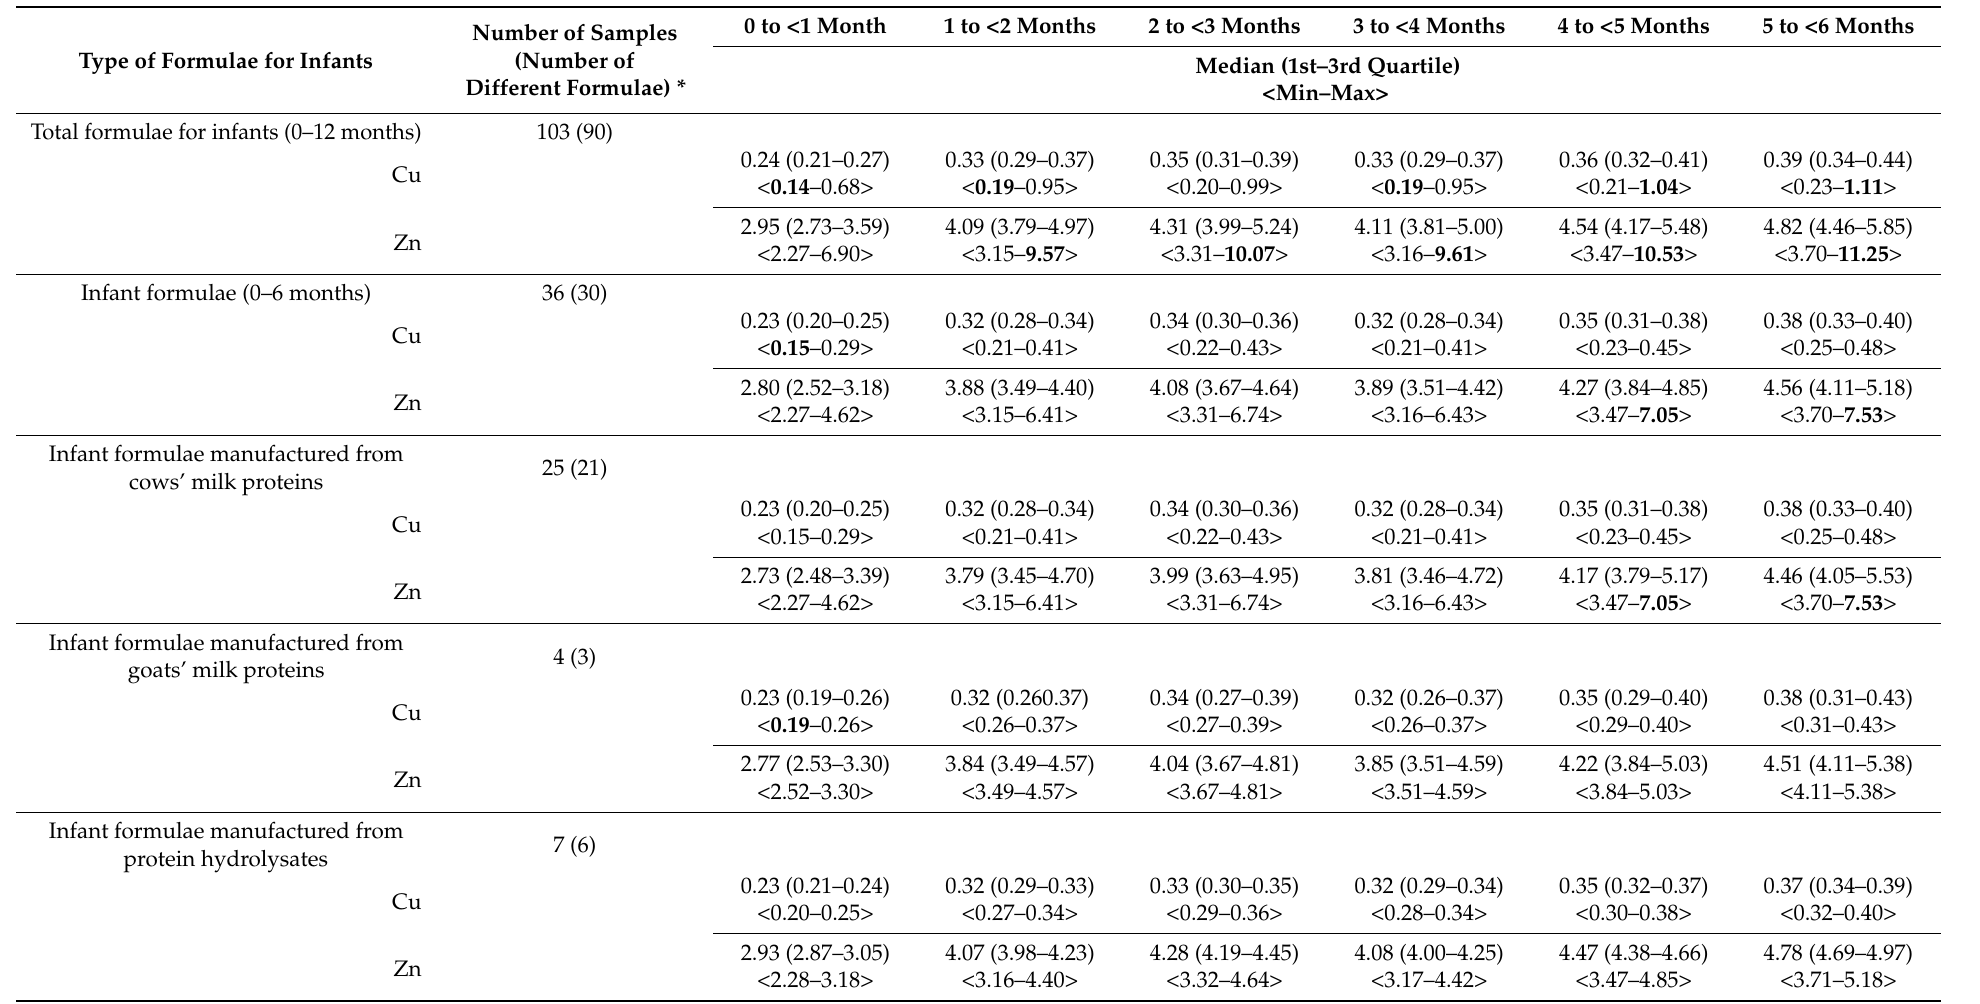
Table 4. Estimated daily intake (mg/day) of copper and zinc with different types of formula for infants (values that does not meet the recommendation are shown in